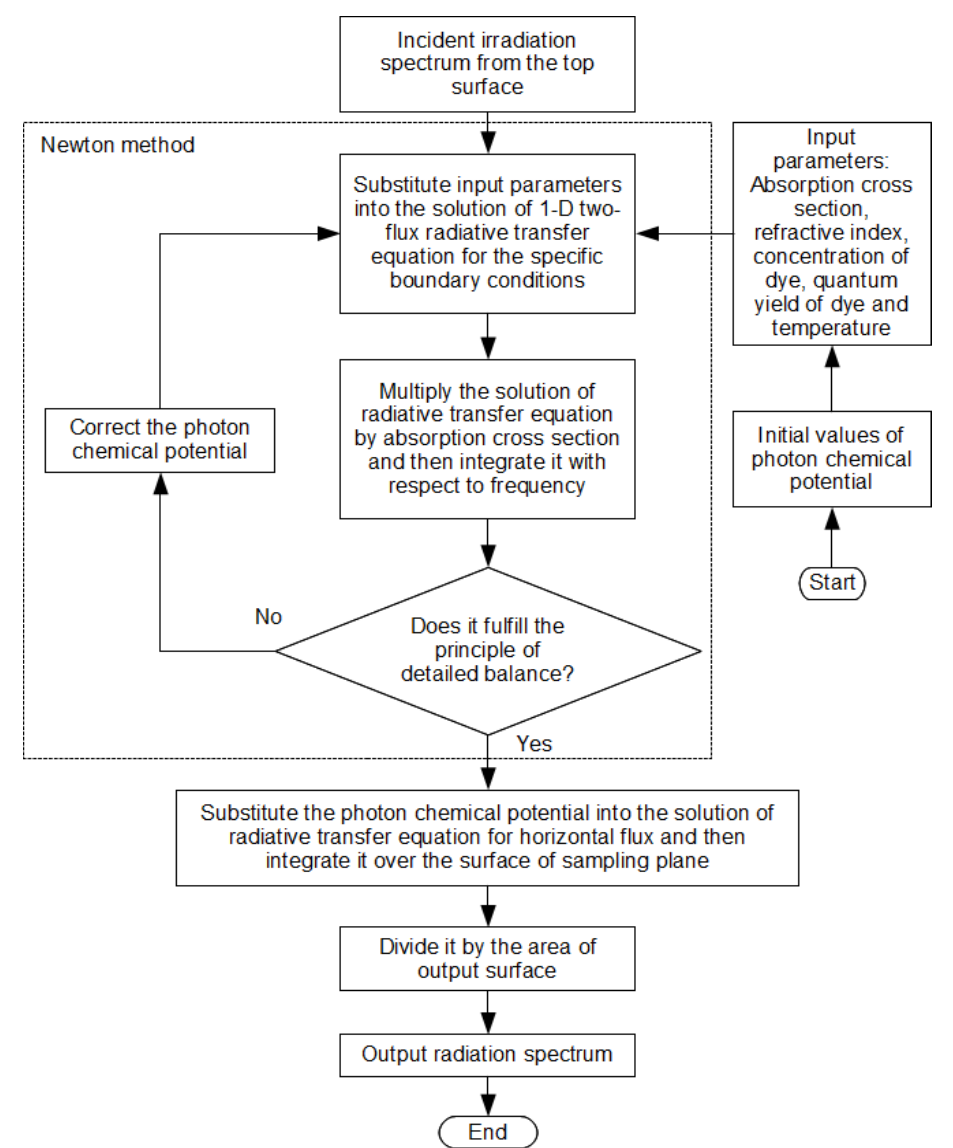
Figure 7. Flow chart of the thermodynamic